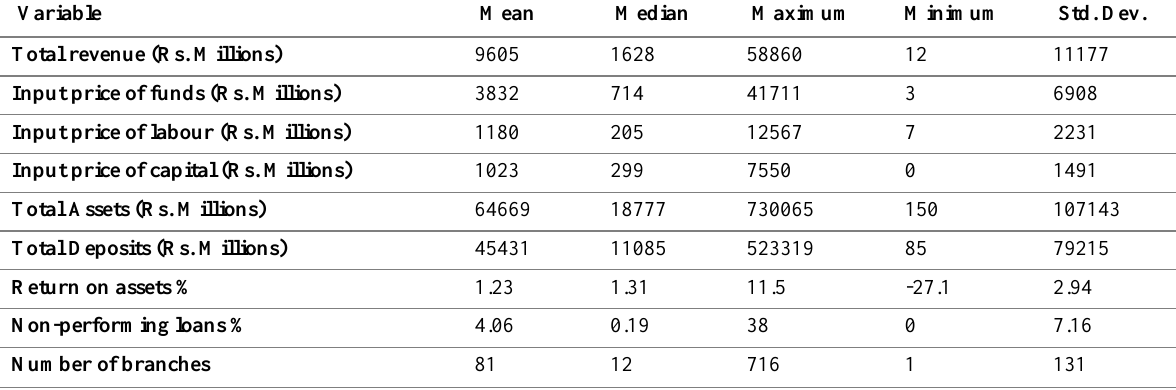
Table 2: Summary Statistics of Sri Lankan banking sector operations 1996-2018